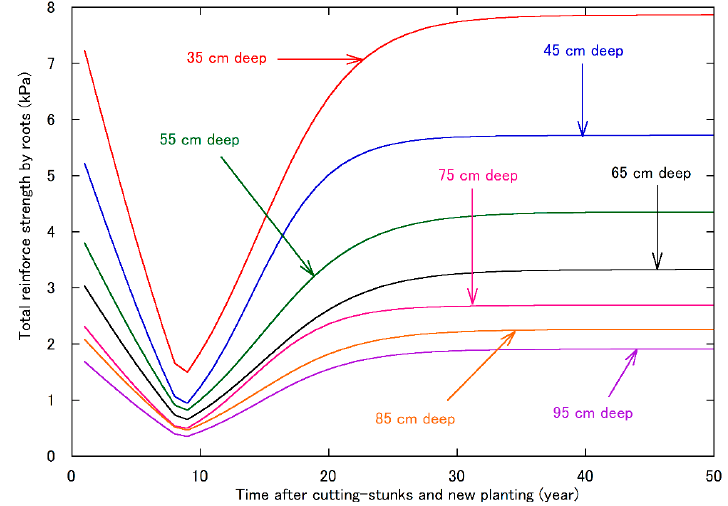
Figure 8. Changes in the total reinforced root strength of Japanese cedar according to the time after stump-cutting and new planting.